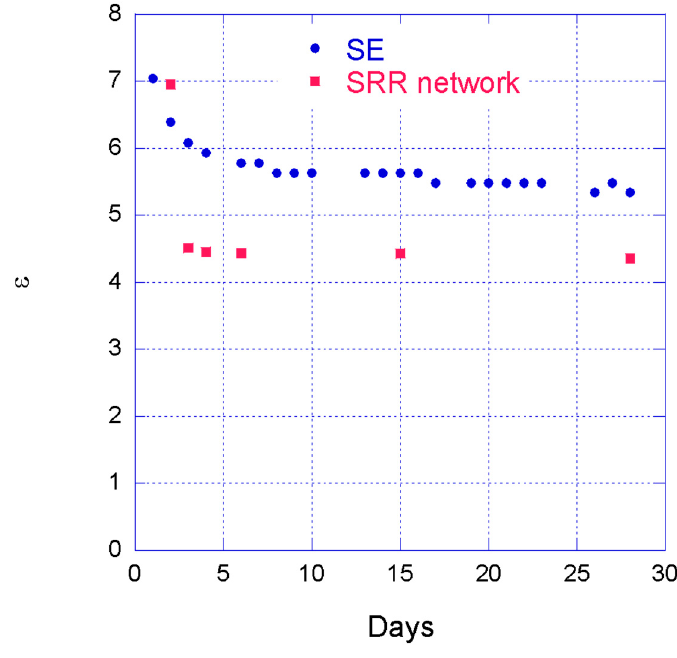
Figure 11. Measured permittivity during the curing of the concrete.